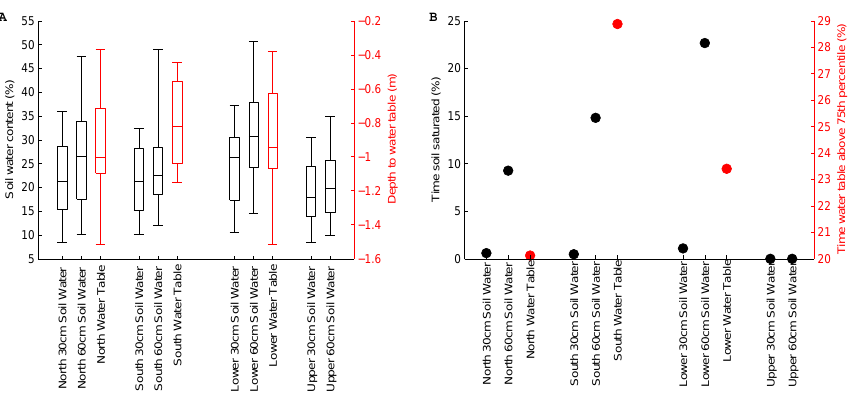
Figure 6. Summary statistics of soil moisture and depth to water table by location. (a) Distributions of measured values. (b) Summary of wet extremes.